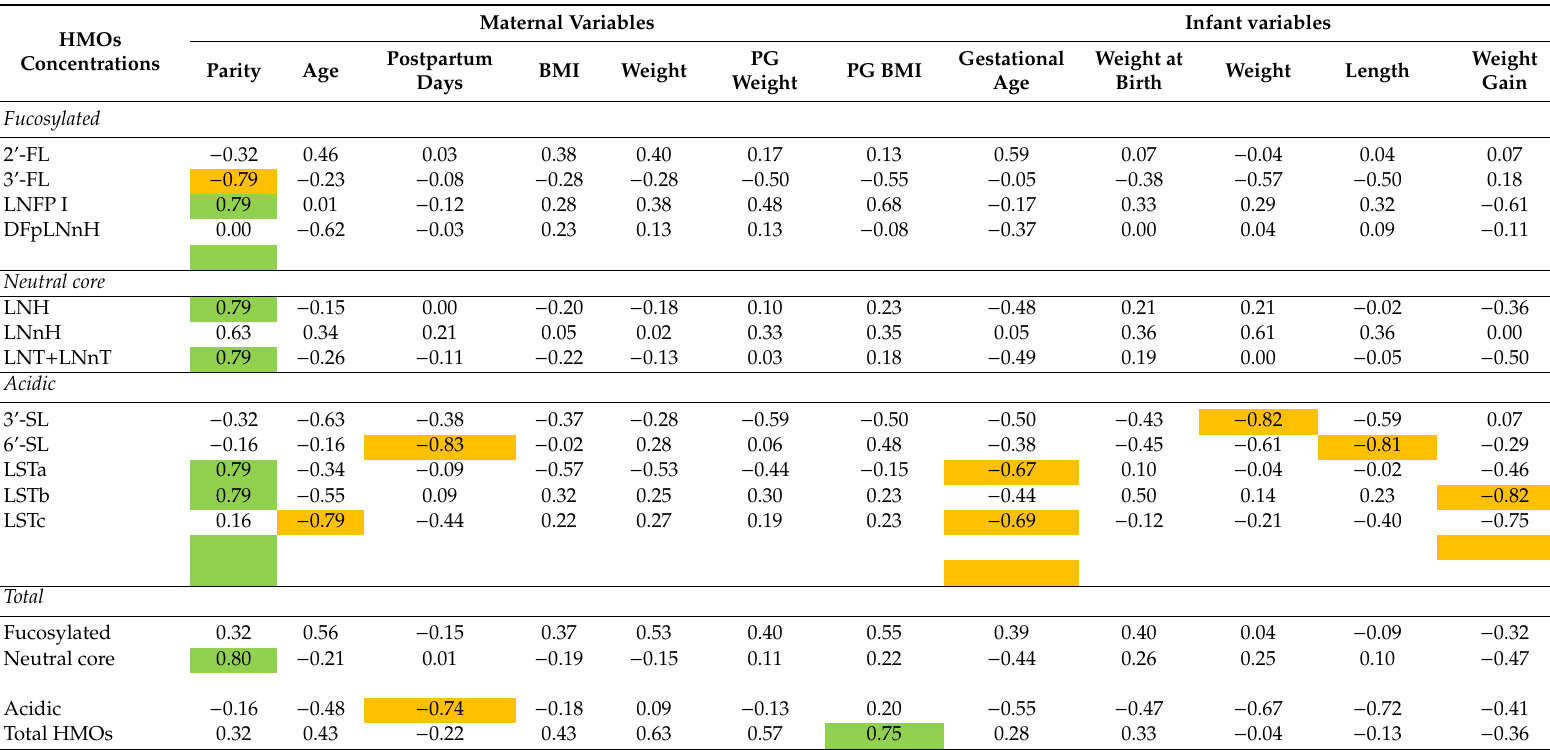
Table A2. Spearman rank correlation coe ffi cient (r) between HMOs concentrations and quantitative clinical variables in Group 3 (Se + Le − ; n = 9). Maternal Variables Infant HMOs Concentrations